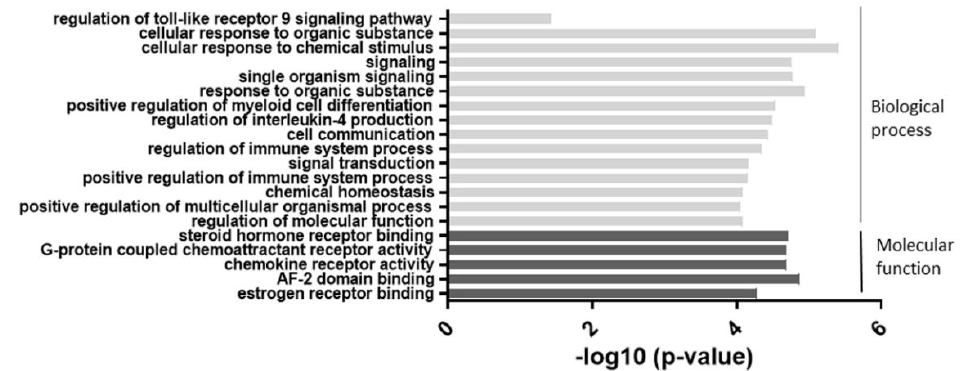
Figure 2. The results of the gene ontology (GO) enrichment analysis of the 74 differentially expressed genes which were suspected miR-877-3p targeted genes in RA-FLS. The enrichment scores (−log 10) of significant enrichment in GO terms are shown. The vertical axis represents the GO categories. The horizontal axis represents the enrichment scores. The p -value indicates the significance of the GO term correlated to the conditions. The smaller the p -value, the more significant the GO term is. MiR-877-3p affected mainly biological processes such as signaling and cellular responses in RA-FLS.